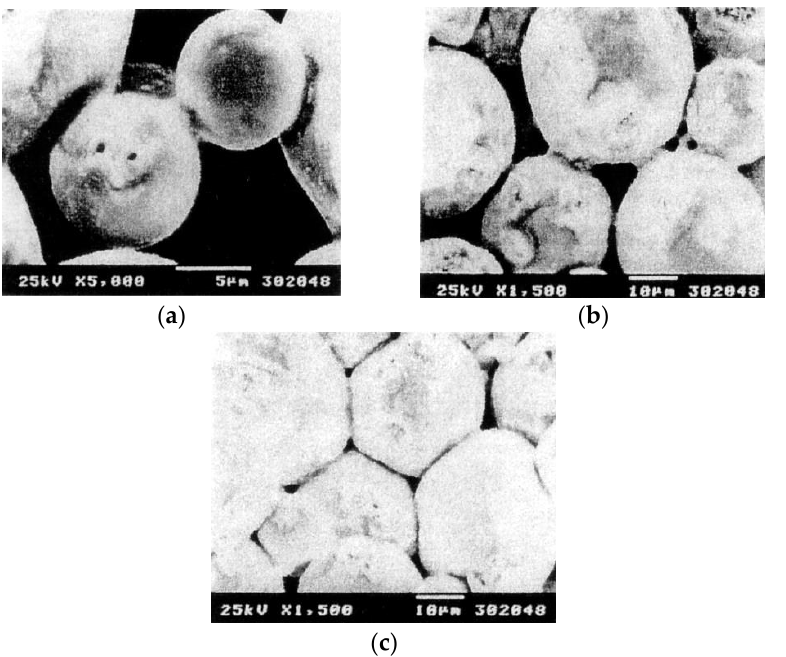
Figure 11. Neck formation example of a spherical bronze alloy powder by SPS: ( a ) The initial stage of neck formation; ( b ) Expansion of neck area; ( c ) Start of plastic deformation and flow (Cu/Sn90/10 wt% SPS conditions/pressure:29 MPa, temp: 773 K, holding time: 2 min. current: 850 A, voltage: 3.9 V).